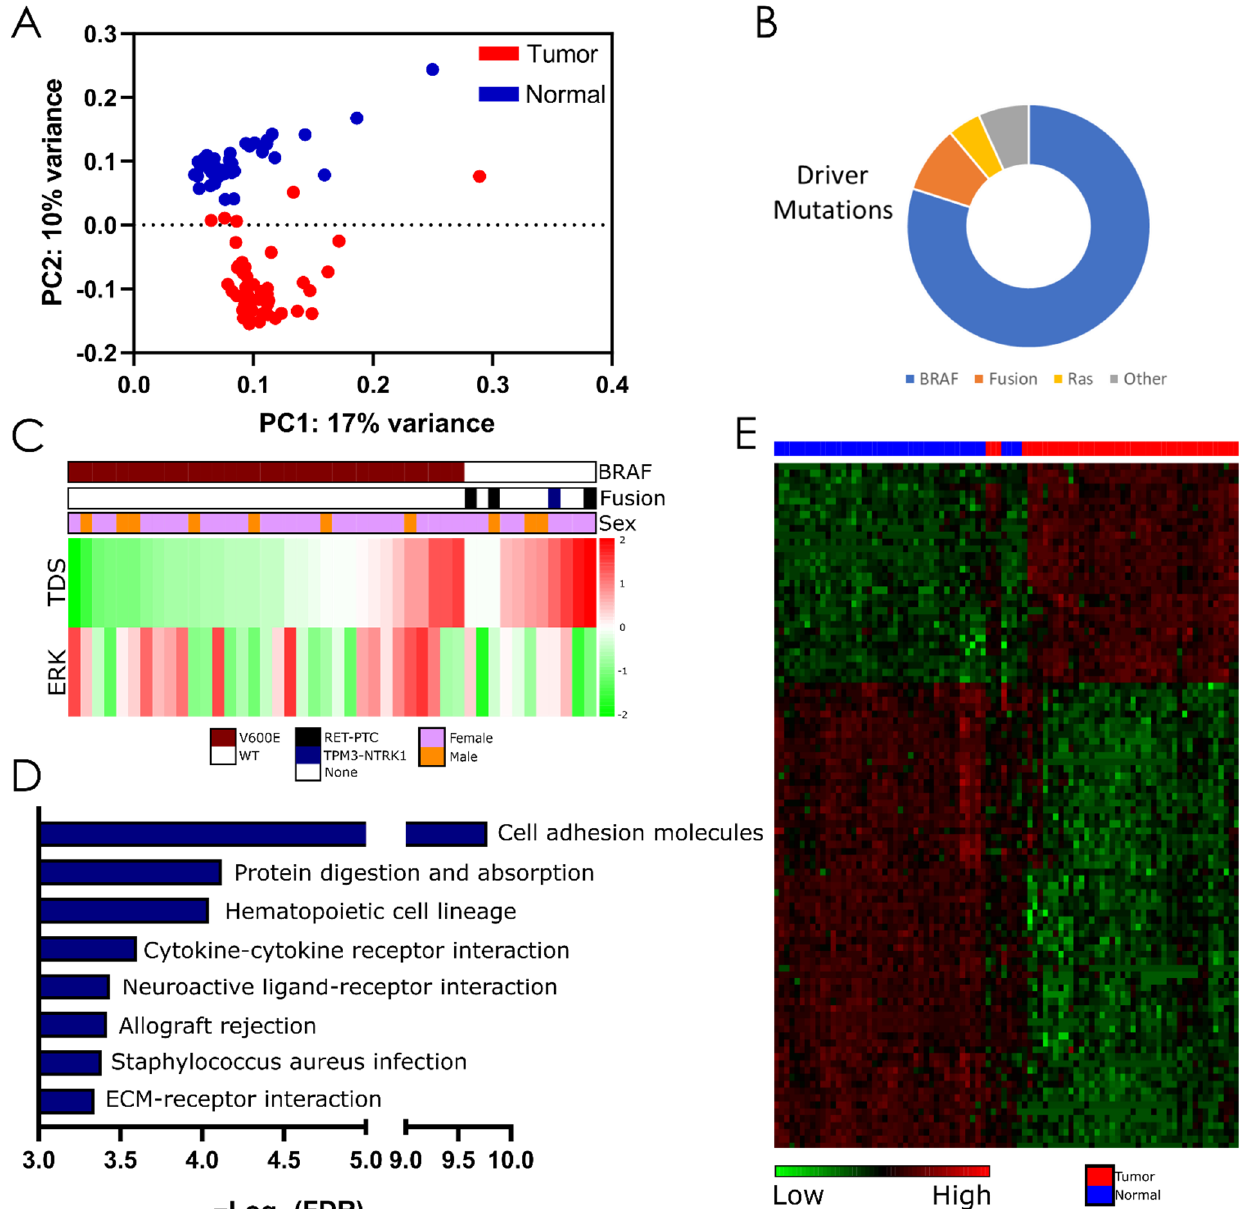
Figure 1. Differential expression analysis between tumor and normal thyroid tissue. ( A ) Principal component analysis of 44 PTC and matched normal tissue. ( B ) Proportion of known driver mutations identified in tumor samples. ( C ) Mutational status, sex, TDS, and ERK score in individual tumors. TDS and ERK scale represent Log2-scaled high and low thyroid differentiation and ERK-activation based on gene signatures [47]. ( D ) Pathway analysis of differentially expressed genes. ( E ) Hierarchical clustering of the top 100 differentially expressed lncRNAs (scaled normalized reads by column). FDR, false discovery rate; TDS, thyroid differentiation